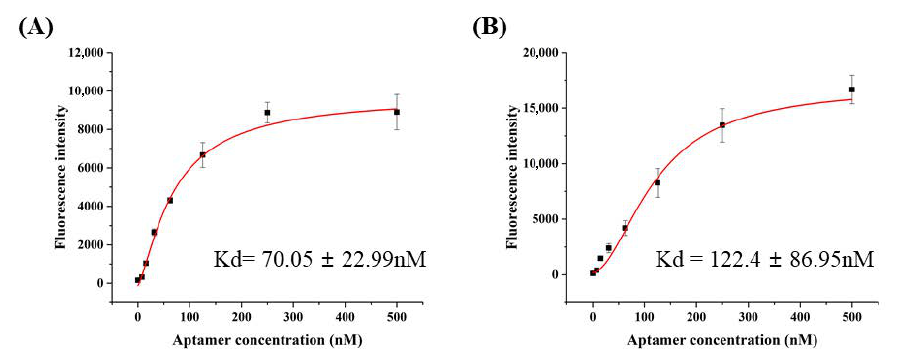
Figure 1. Characterization of aptamers via fluorescence quenching and recovery assay. ( A ) Binding affinity of HBA, Kd = 70.05 nM. ( B ) Binding affinity of HBA2, Kd = 122.4 nM.